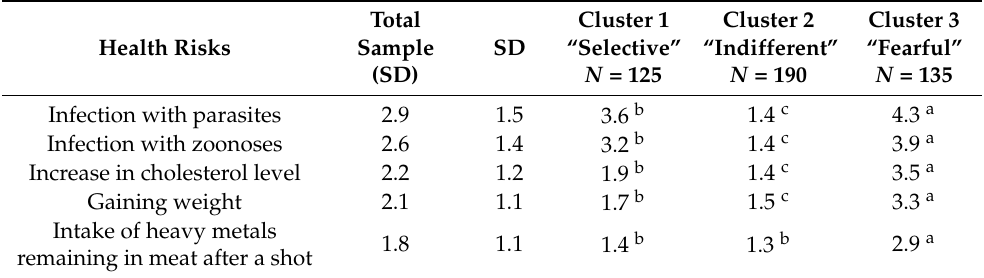
Table 2. Clusters identified according to the participants’ opinions on health risk factors associated with the consumption of game (mean value ± SD *; N = 450, Poland).